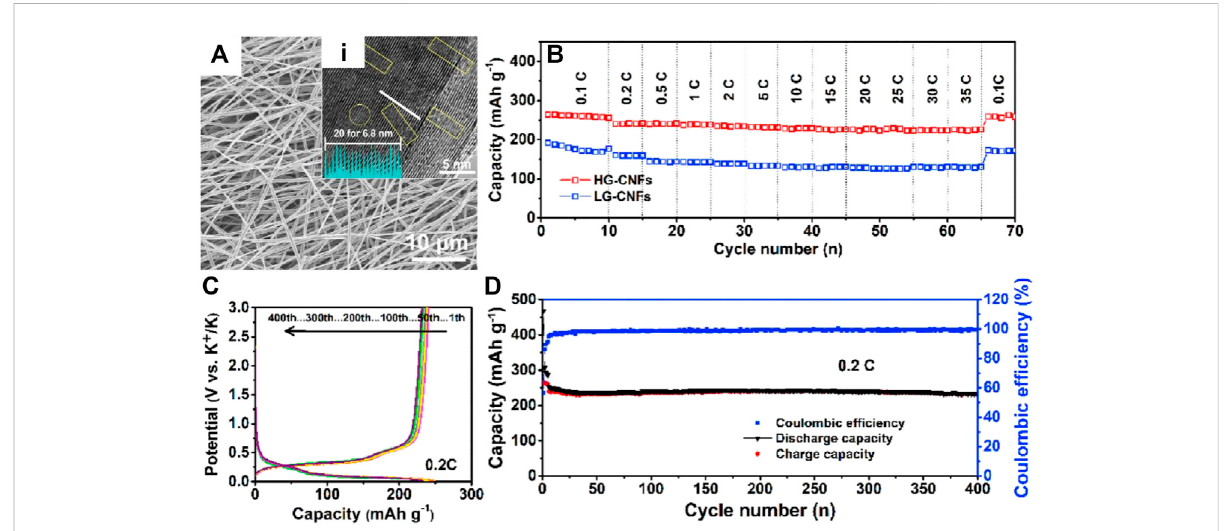
FIGURE 1 (A) SEM and (i) HRTEM images of HG-CNFs. (B) Comparison of the rate capability from 0.1 to 35 C of lowly and highly graphitized carbon nano fi bers (LG- CNFs and HG-CNFs). (C) The charge-discharge curvesafter differentcyclesat 0.2 C (D) Long-term cyclestability and its